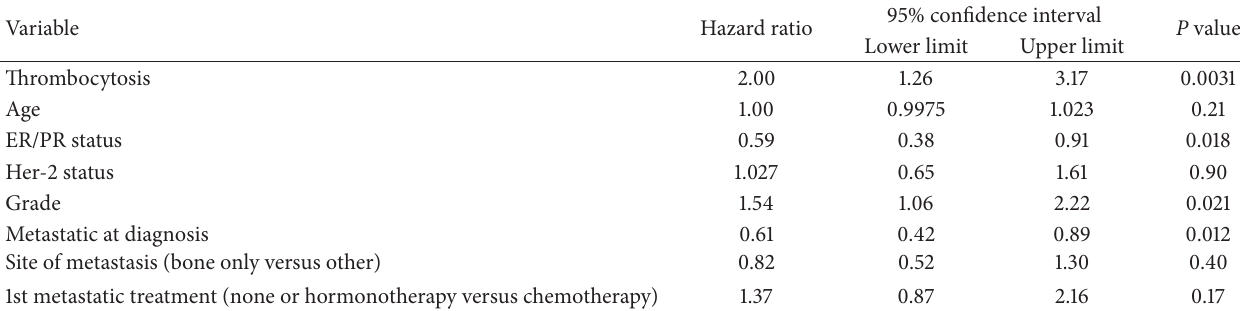
Table 3: Multivariate Cox regression analysis of parameters possibly related to progression free survival of metastatic breast cancer